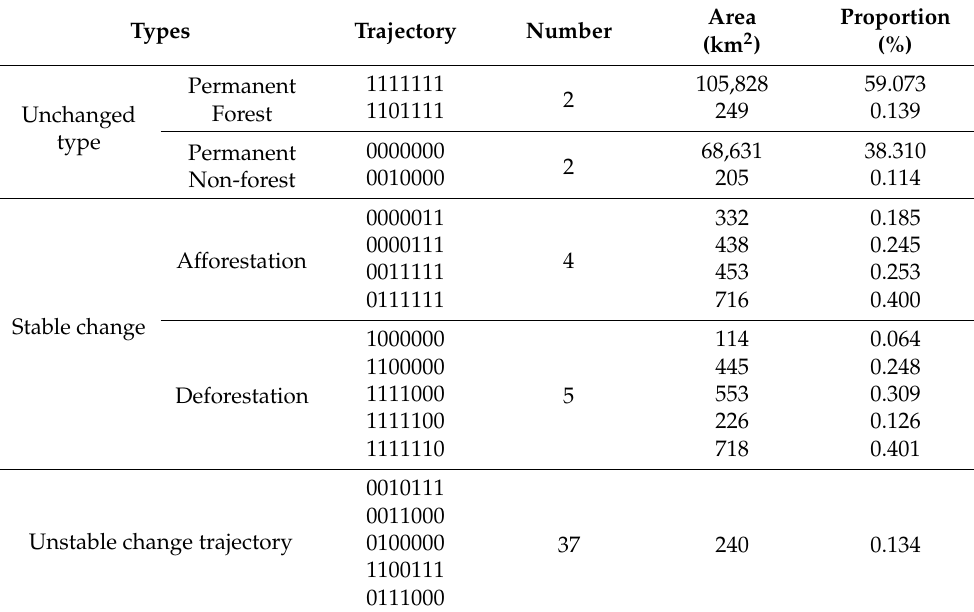
Table 4. Reclassification of change trajectories to three types namely unhanged, stable and